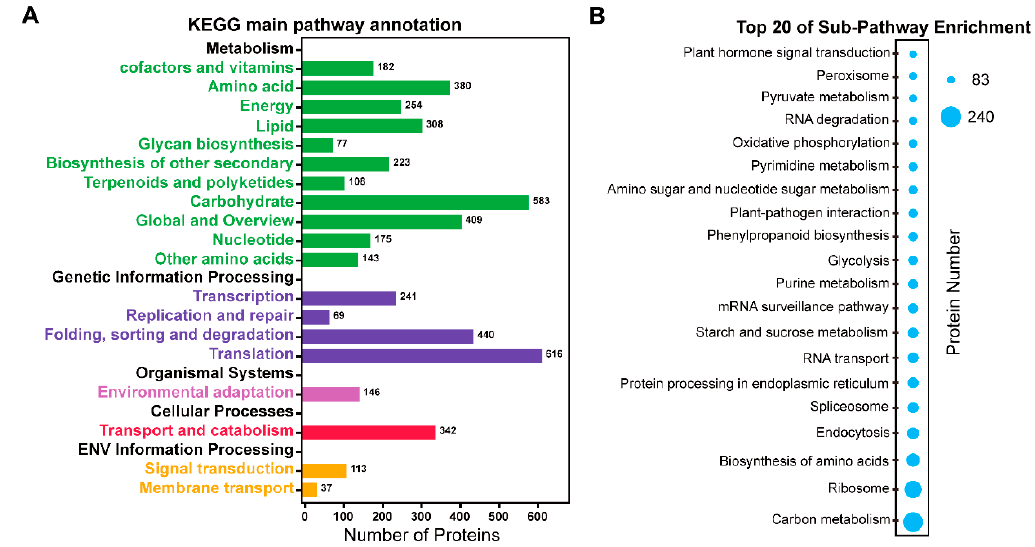
Figure 6. KEGG pathway analysis of all the identified proteins. KEGG pathways for the identified 3592 proteins are presented ( A ). The number of proteins enriched in the KEGG database is marked in the right side. Then, the most abundant 20 KEGG pathways are highlighted ( B ). The size of the circular ring, ranging from 83 to 240, stands for the number of proteins involved in these pathways.